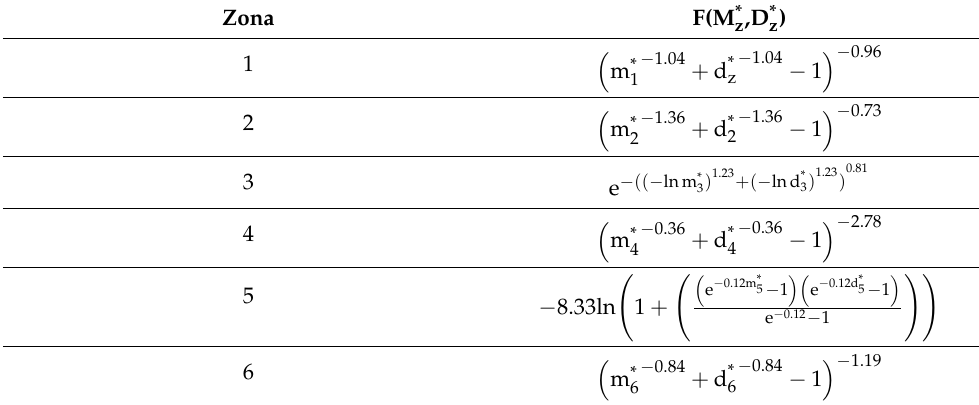
Table 18. The joint cumulative distribution function of magnitude and depth of earthquakes in Cluster Type